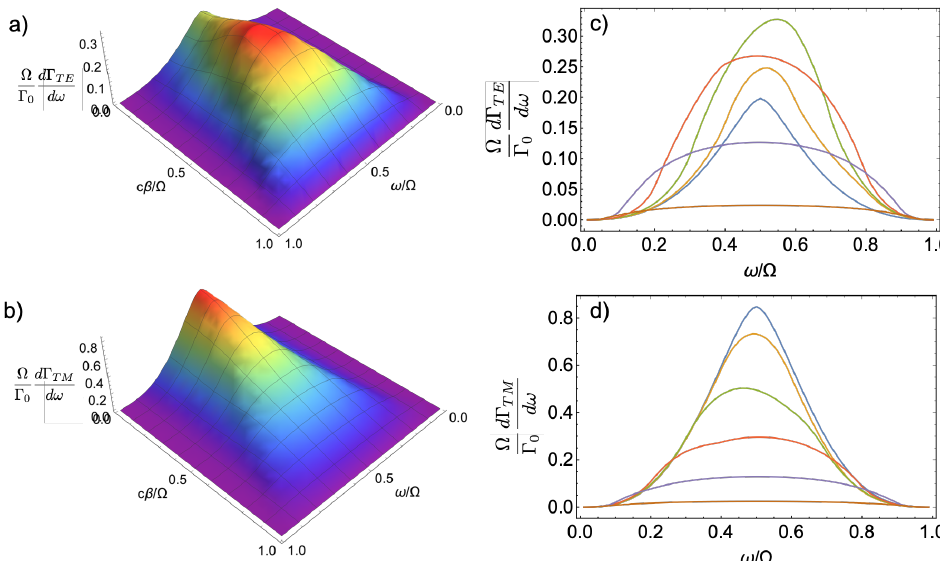
Figure 5. Spectral emission rate of DCE photons versus frequency and momentum kick for ( a ) TE and ( b ) TM photons. Panels ( c , d ) show cuts of the spectrum for TE and TM polarizations, respectively, at fixed c β / Ω = 0 (blue), 0.2 (orange), 0.4 (green), 0.6 (red), 0.8 (purple), and 0.95 (brown). We assume a monolayer with in-plane periodic boundary conditions. The spectral rates are normalized